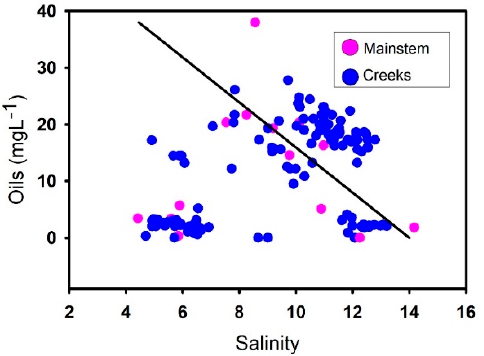
Figure 11. Mixing diagram for general oils, South River main stem, and triblets research sites.